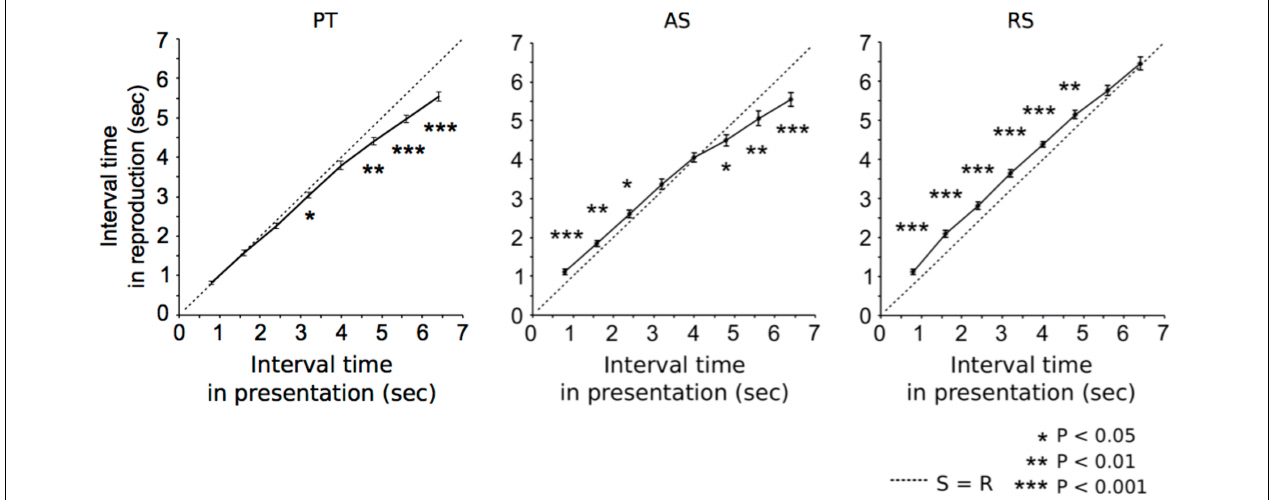
FIGURE 2 | Grand-averaged time intervals (solid lines) that participants reproduced in paired tone (left), accelerando series (middle), and rhythm series sessions (right). At S = R (dashed lines), time intervals between stimuli equals reproductions. The asterisks indicate significant differences from S = R. The error bars indicate the standard error of the